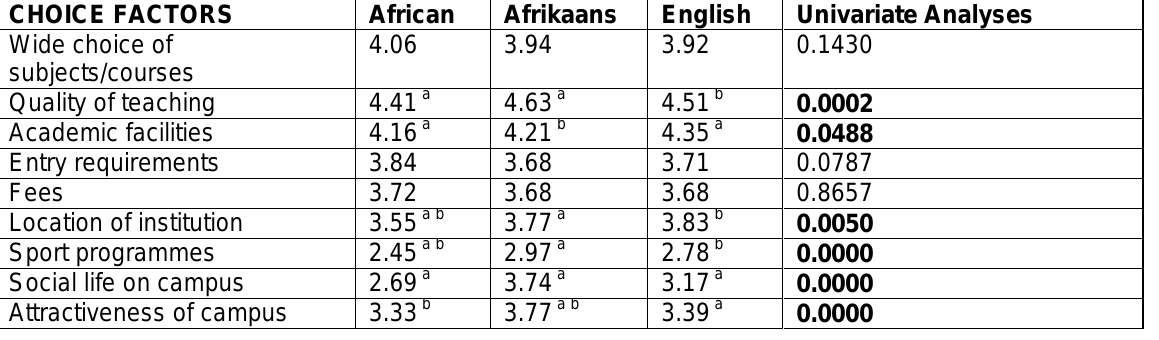
Table 4: Mean values and MANOVA results for different language groups CHOICE